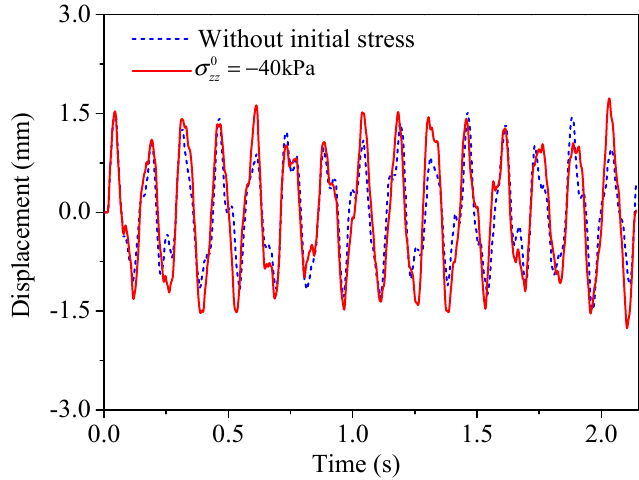
Figure 12. Averaged dynamic responses of the top edge of the periodic foundation under SV wave with f = 7 Hz.